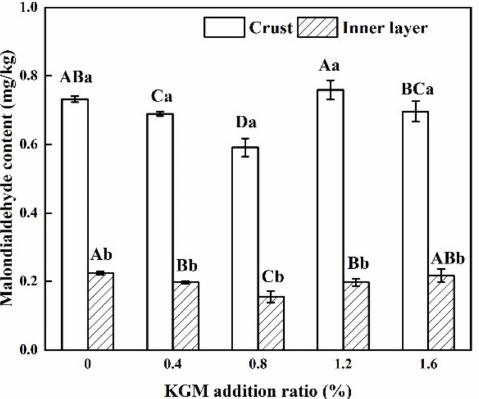
Figure 4. Malondialdehyde content of fried battered fish nuggets with different proportions of KGM. Note: Different capital letters indicate that there are significant differences between different conditions ( p < 0.05). Different lowercase letters indicate that there are significant differences between the crust and the inner layer in the same condition ( p <